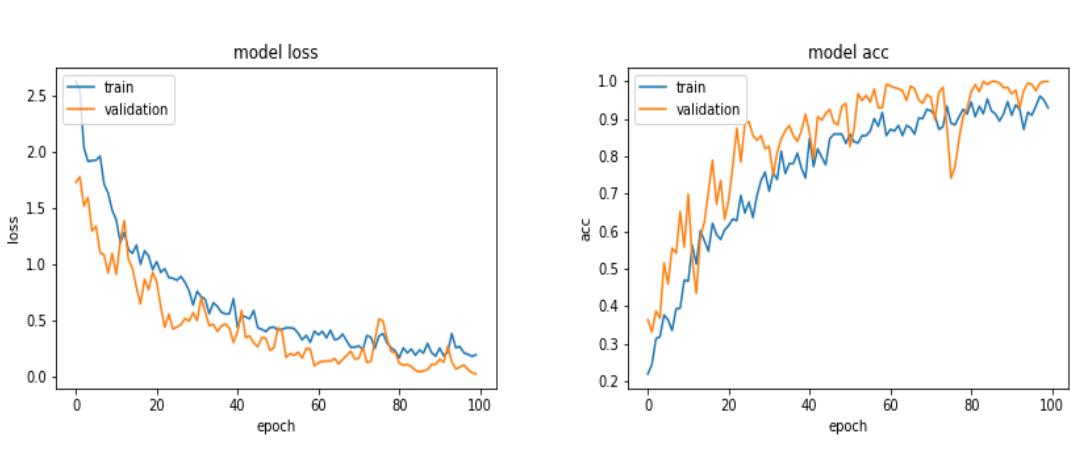
Figure 4. Loss function and the accuracy as a function of the epoch